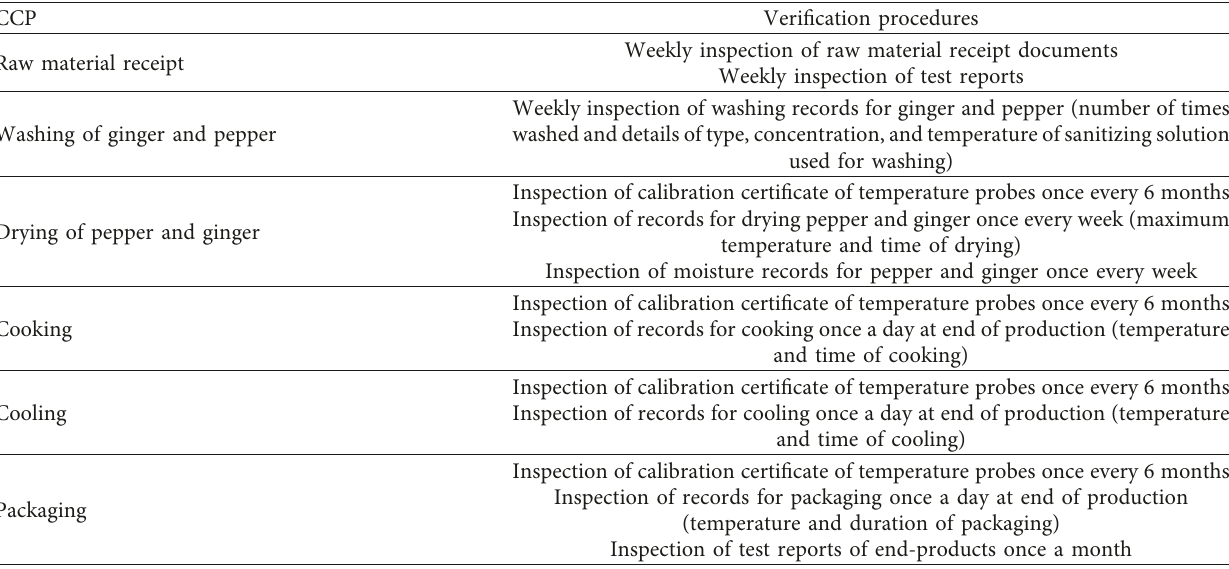
Table 5: Verification